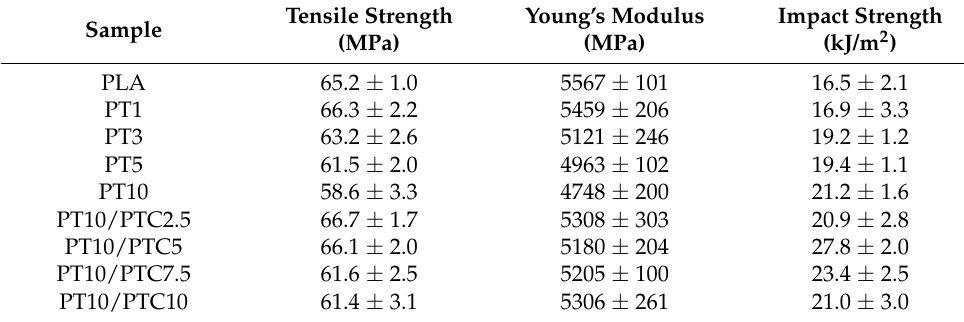
Table 2. Mechanical properties of PLA/TPU blends and PLA/TPU/PTC blends.